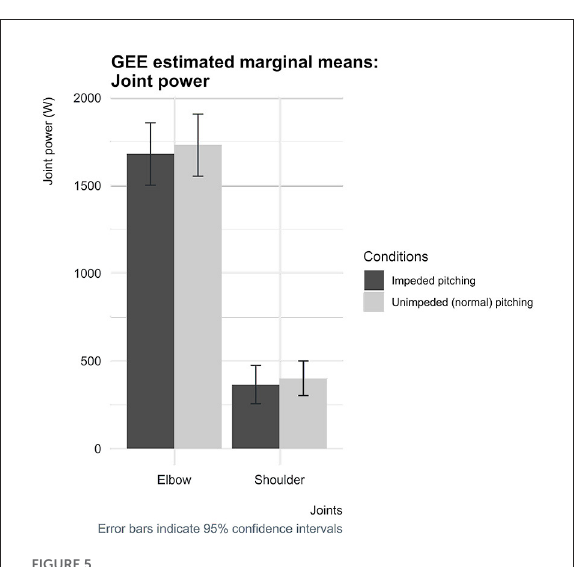
FIGURE5 Estimated marginal means for the peak joint power across the shoulder and elbow for both conditions with corresponding 95% confidence interval error bars.